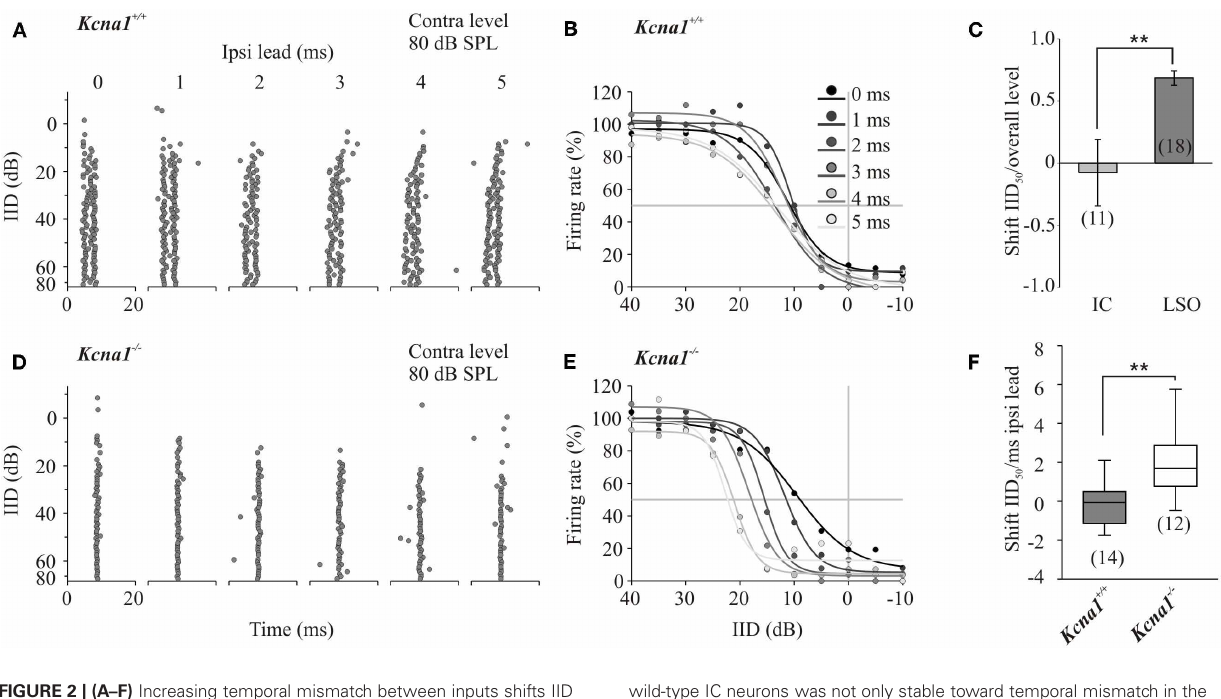
FIGURE 2 | (A–F) Increasing temporal mismatch between inputs shifts IID functions in the Kcna1 − / − but not the wild-type mice. Instead of the simultaneous onset of the ipsi- and contralateral stimulus, the ipsilateral inhibitory stimulus was presented 1–5ms in advance. (A) Dot raster displays of a representative Kcna1 + / + neuron show no systematic change in response to different ipsilateral lead times. (B) IID functions of the same neuron shown in A did not vary in their IID 50 values. (C) IID-sensitivity in